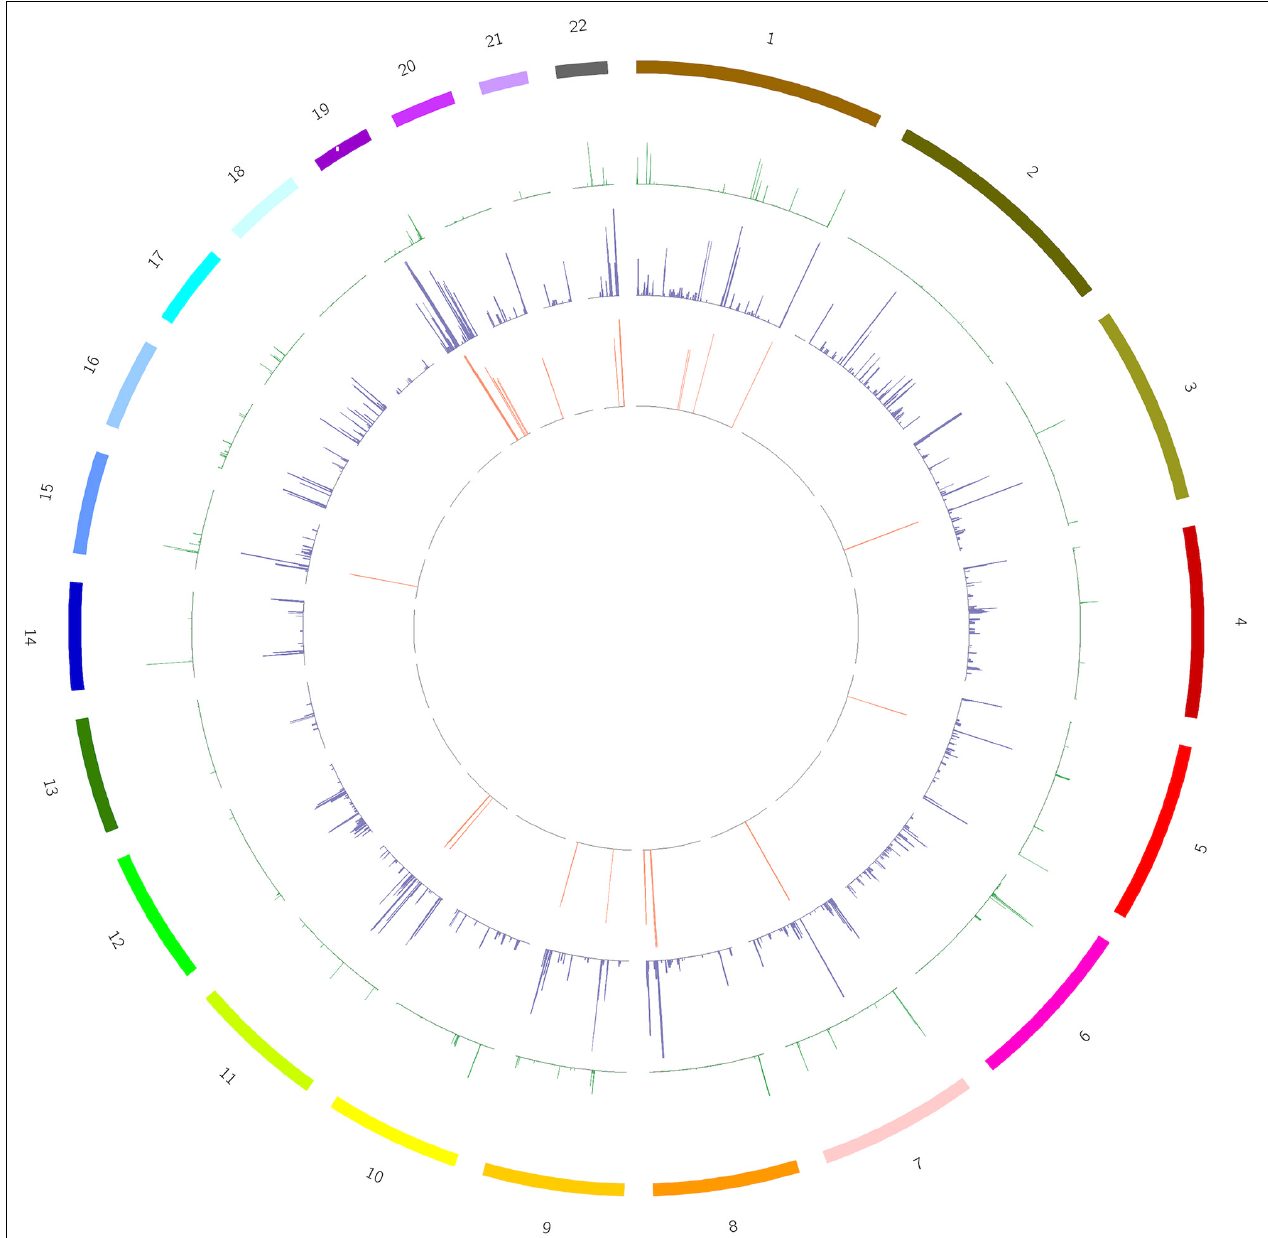
FIGURE 2 | A circos plot depicts the chromosomal distribution, gene expression and copy number variations (CNV) in case and control groups. From outside to inside: Circle 1: Chromosomes, Circle 2: CNV in the control group, Circle 3: CNV in the case group, Circle 4: 168 genes screened out. The heights of circles 2, 3, and 4 represent the proportion of samples of CNV or genes in the corresponding group (CNV samples/total samples in the group).